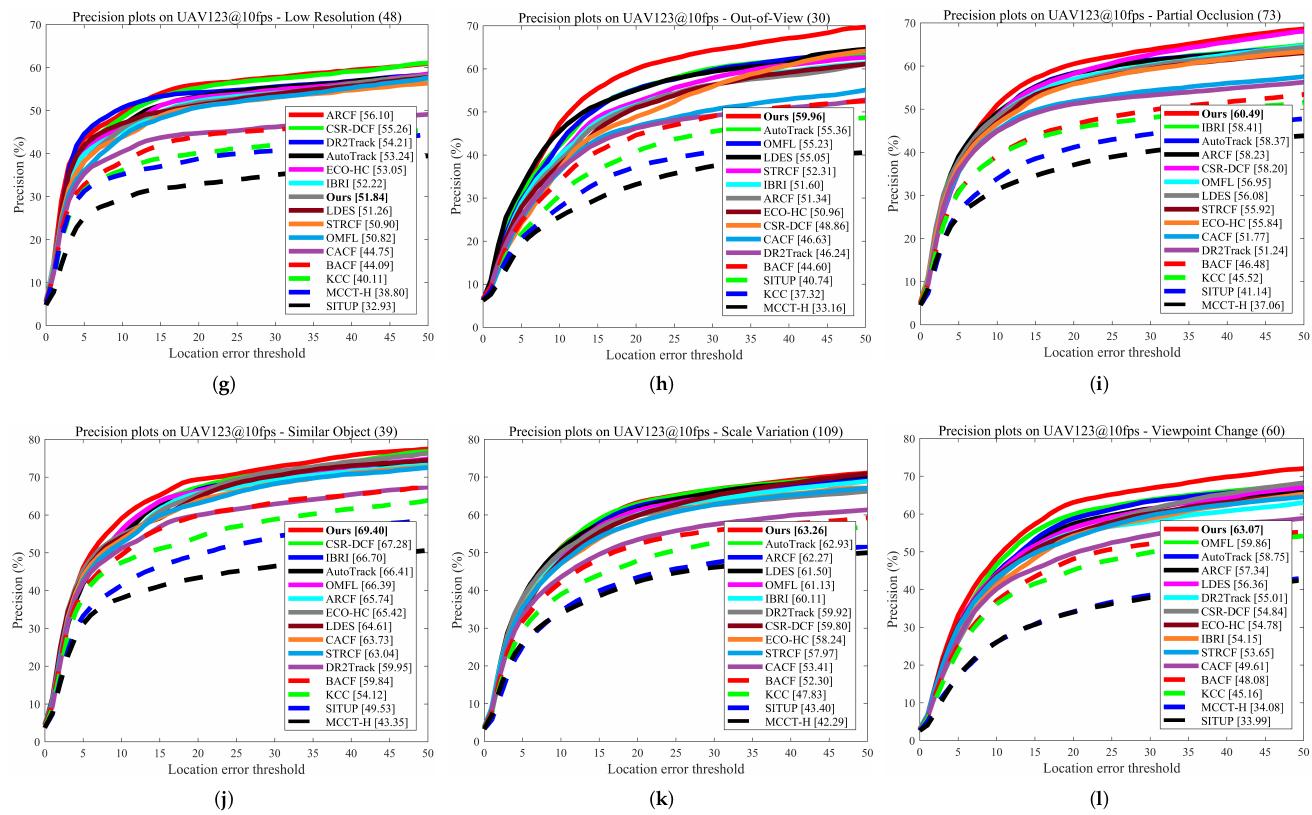
Figure 9. Precision plots on different attributes of the UAV123@10fps [45] benchmark. ( a ) Aspect ratio change (ARC). ( b ) Background clutter (BC). ( c ) Camera motion (CM). ( d ) Fast motion (FM). ( e ) Full occlusion (FOC). ( f ) Illumination variation (IV). ( g ) Low resolution (LR). ( h ) Out-of-view (OV). ( i )